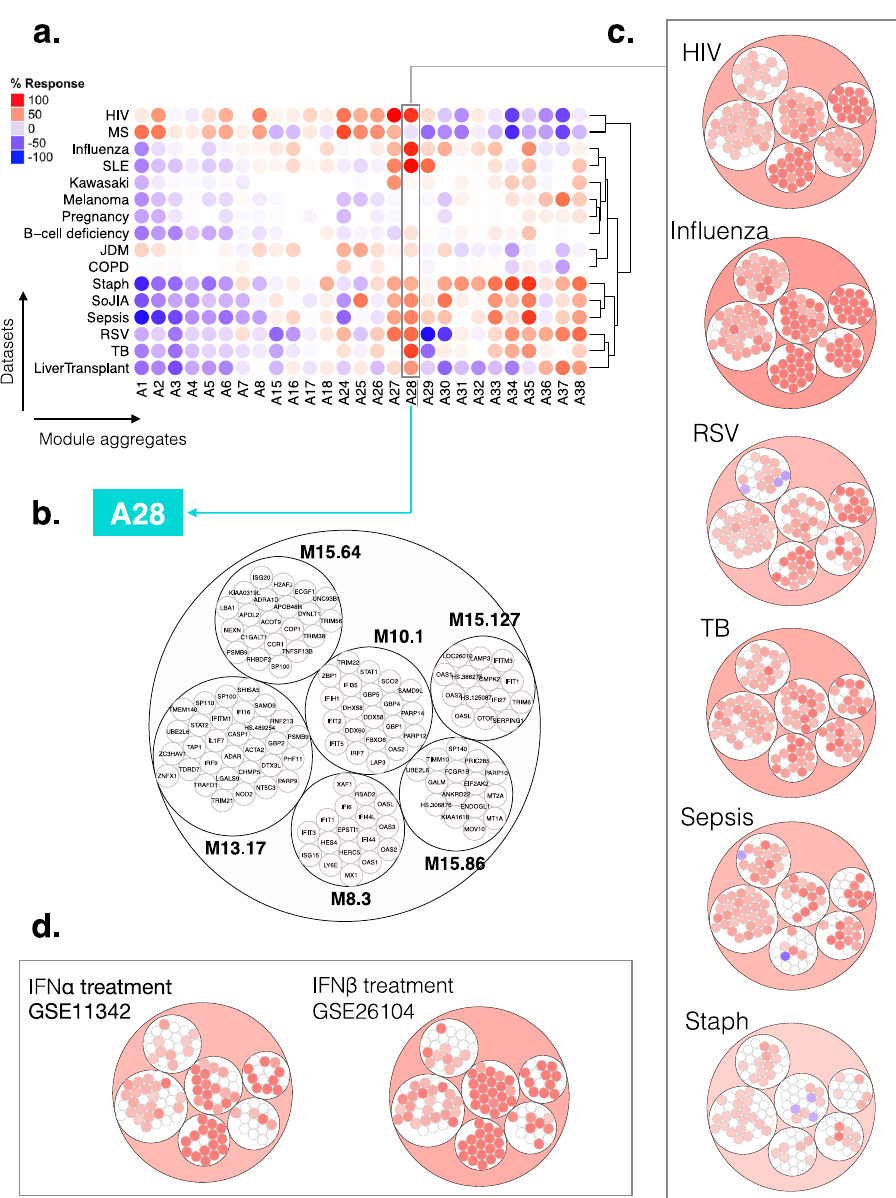
Fig. 7 Module aggregate abundance patterns across the 16 disease or physiological states. a Patterns of changes in transcript abundance at the aggregate and cohort levels. Each column on the heatmap corresponds to a “ module aggregate ” , numbered A1 to A38. Modules A9 – A14 and A19 – A24 were excluded as they each comprised only one module. Each row on the heatmap corresponds to one of the 16 datasets used to construct the module repertoire. A red spot on the heatmap indicates an increase in abundance of transcripts comprising a given module cluster for a given disease or physiologic state. A blue spot indicates a decrease in abundance of transcripts. No color indicates no change. Disease or physiological states were arranged based on the level of similarity in the patterns of aggregate activity, determined via hierarchical clustering. b Representation of the modules and genes constituting aggregate A28. The circle plot represents the six modules constituting aggregate 28, and the transcripts constituting each of the modules. Some genes on the Illumina BeadArrays can map to multiple probes, which explains the few instances where the same gene can be found in different modules. c Patterns of changes in transcript abundance at the module level and gene level for aggregate A28. The circle plots illustrate the changes at the gene level for this aggregate for 6/16 datasets. The position of the genes on each of these plots is the same as shown in panel B. Genes for which transcript abundance is changed are shown in red (increase) or in blue (decrease). d Patterns of changes in transcript abundance at the module and gene levels for aggregate A28 in subjects treated with IFN- α or IFN- β . The circle plots show changes in abundance of A28 transcripts in patients with hepatitis C infection treated with IFN- α [GSE11342 31 ] or patients with MS treated with IFN- β [GSE26104 32 ] (HIV: human immunode fi ciency virus, RSV: respiratory syncytial virus, TB: Tuberculosis, Staph: Staphylococcus aureus infection, SLE: systemic lupus erythematosus, MS: multiple sclerosis, JDM: juvenile dermatomyositis, COPD: chronic obstructive pulmonary disease, SoJIA: systemic onset juvenile idiopathic arthritis, IFN α : interferon alpha, IFN β : interferon beta).